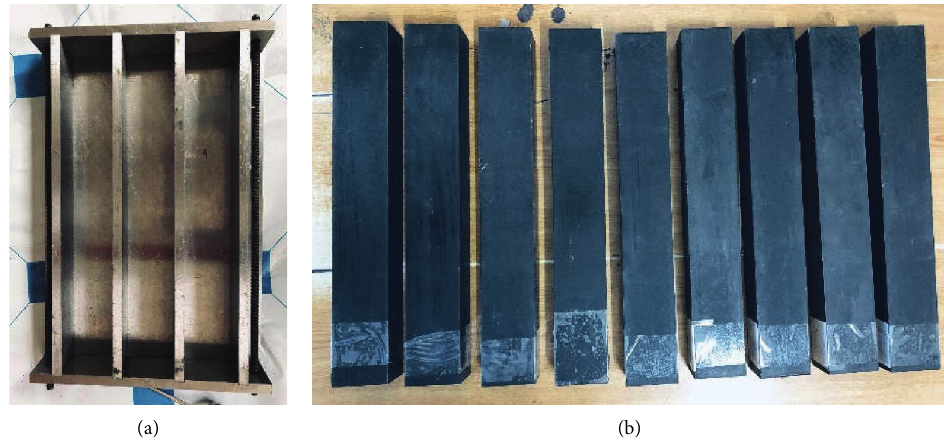
Figure 10: (a) Mould and (b) specimens of polyurethane